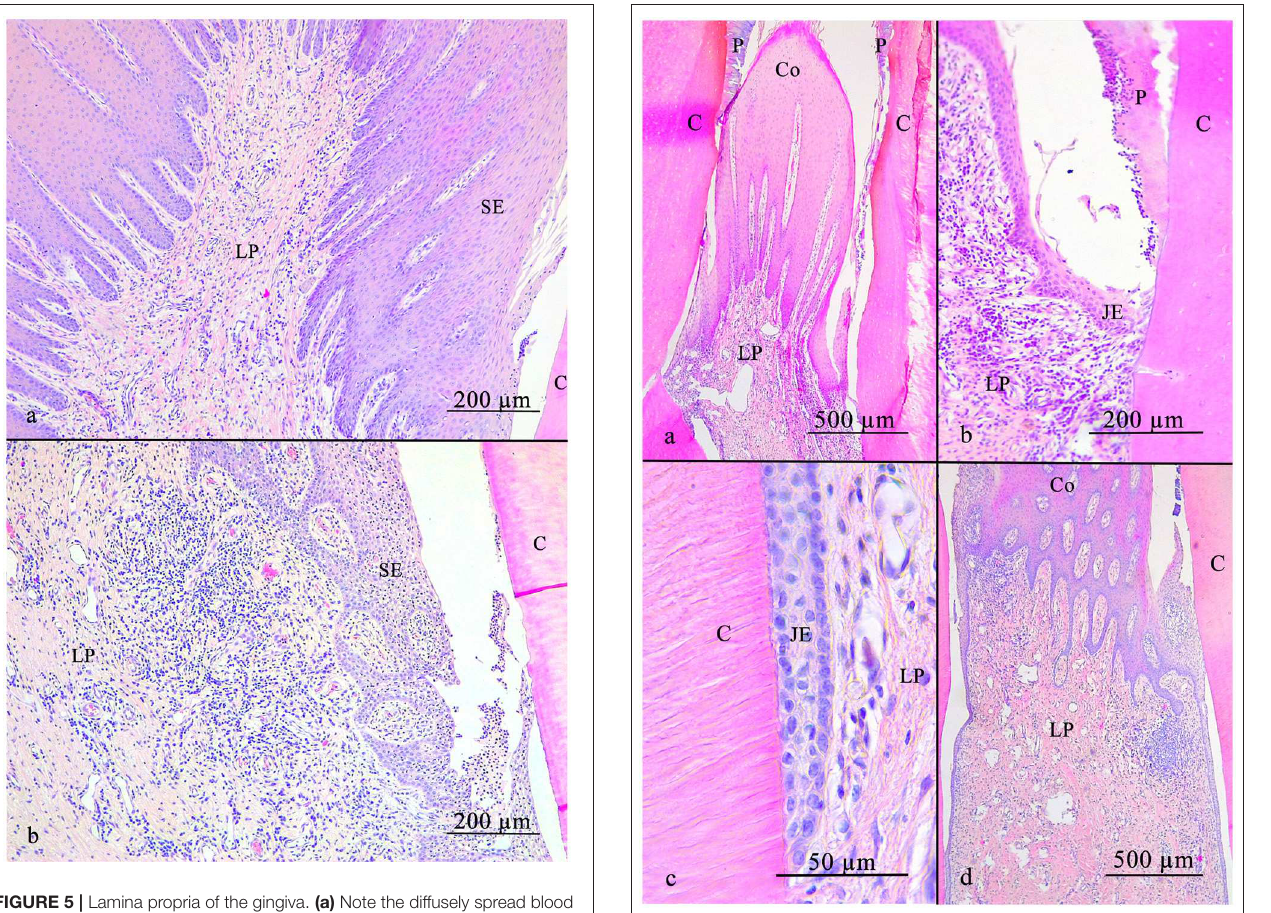
non-keratinized stratified squamous epithelium with rete pegs (a) . In direction of the tooth the epithelium flattens (b) and finally connects to the tooth (c) . The lamina propria includes leucocytic infiltrates in a low number spread all over the connective tissue and in high numbers locally near the epithelium (d) . C, cementum; JE, junctional epithelium; LP, lamina propria; P, plaque; Co,